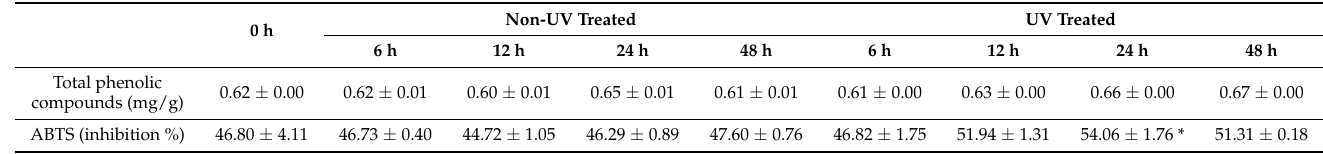
Table 3. TPC and ABTS assay of UVB-treated purple kohlrabi